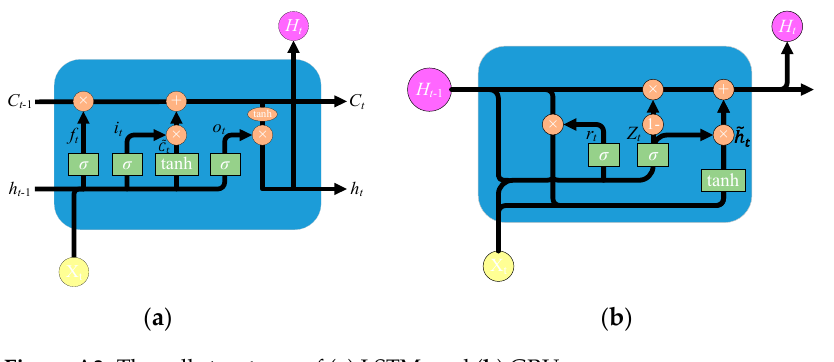
Figure A3. The cell structures of ( a ) LSTM; and ( b ) GRU.